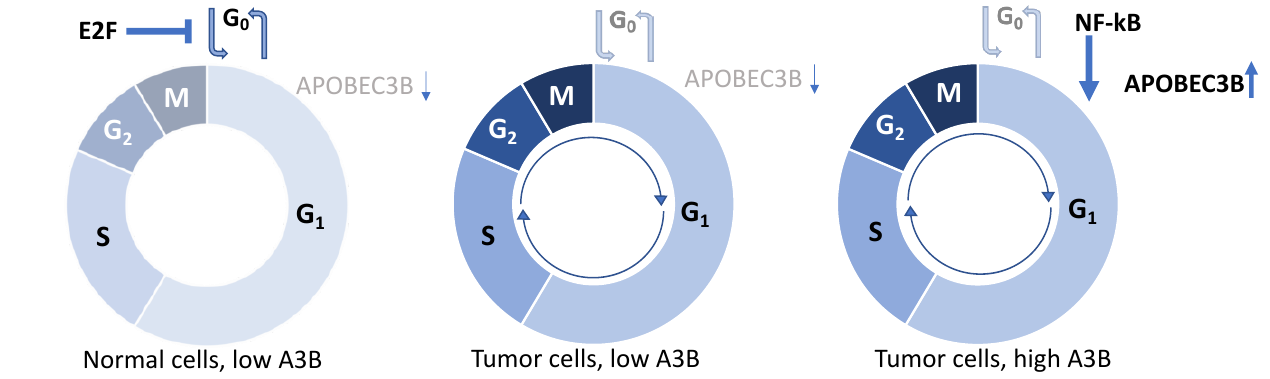
Figure 5. Model explaining current results. In normal, non-proliferating cells in G 0 , E2F inhibits A3B gene expression (left). During proliferation, such as in rapidly dividing tumor cells, E2F no longer inhibits A3B expression (middle), yet for A3B to be overexpressed in a subset of tumors, stimulation during proliferation is required through the NF-kB pathway (right).